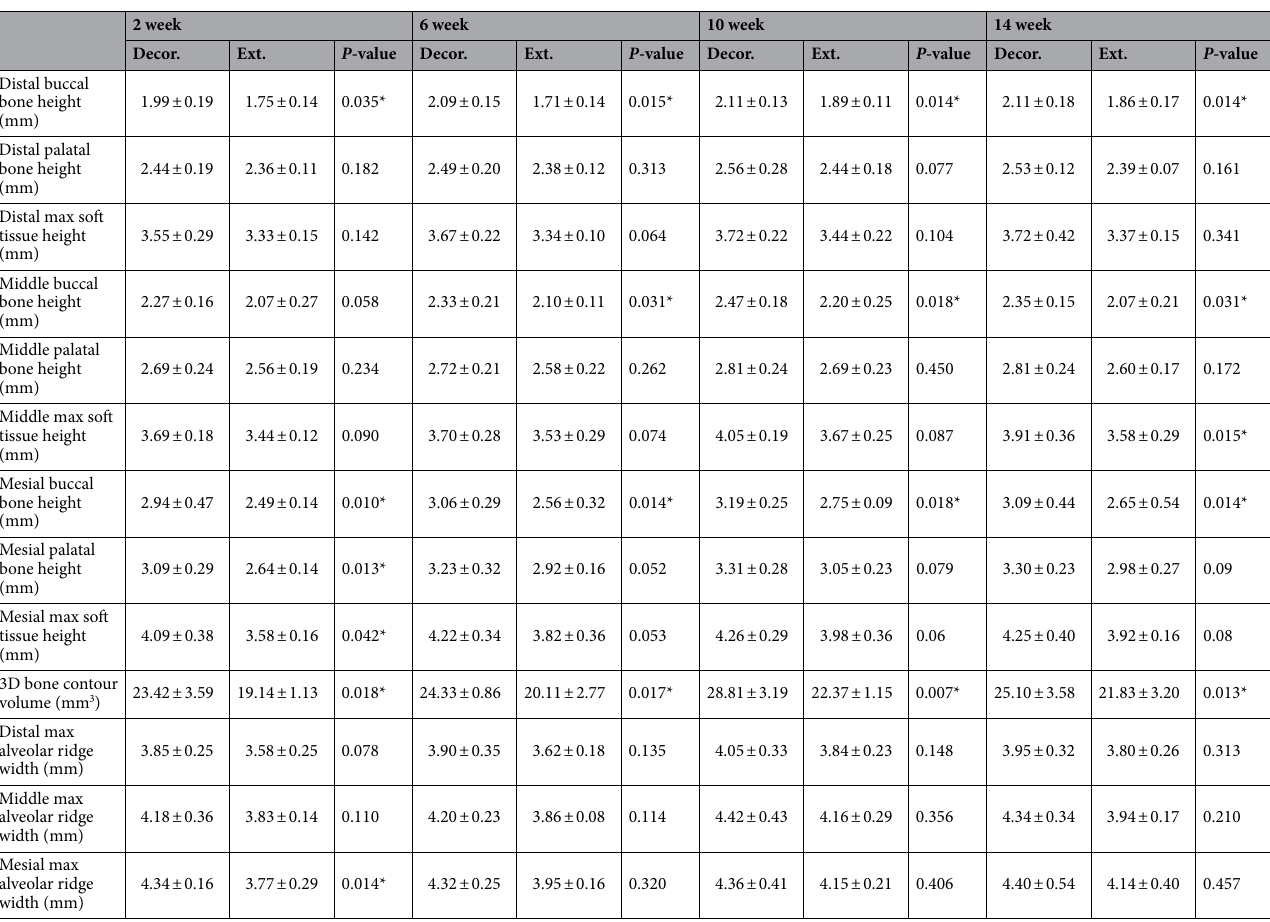
Table 1. Micro-computed tomography assessments of alveolar bone and soft tissue dimension comparing the decoronation (Decor.) and contralateral extraction (Ext.) maxillary first molar sites at 2, 6, 10, and 14 weeks. n = 6 per group; Statistically significantly different at * P < 0.05; Data are represented as mean ± standard